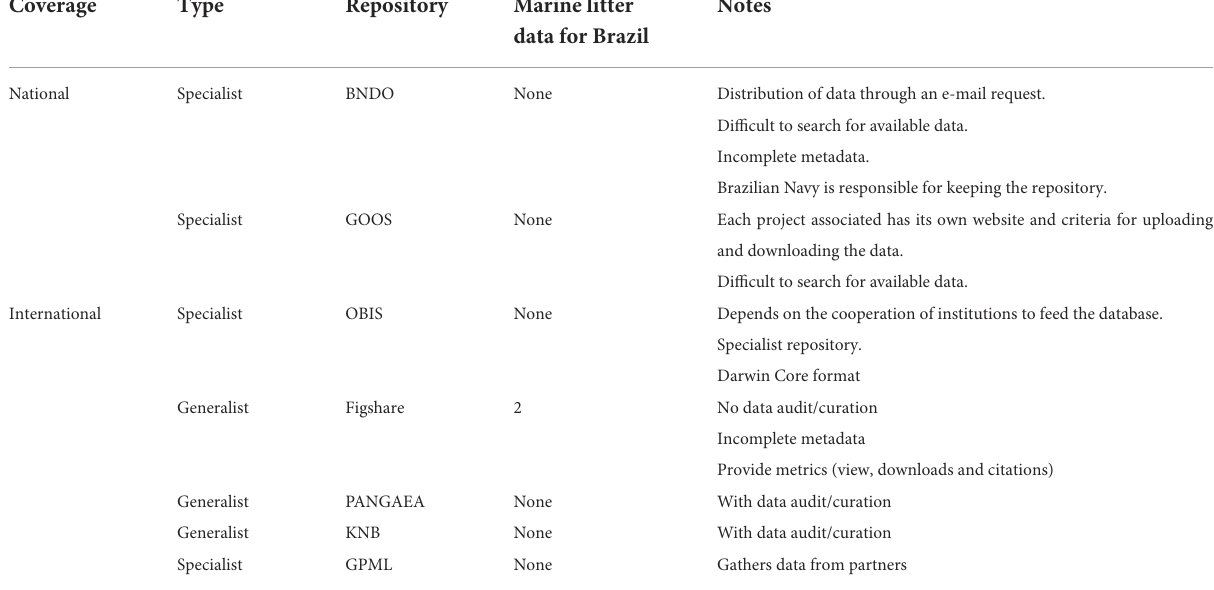
TABLE 1 A summary of data repositories and potential of data related to marine litter in